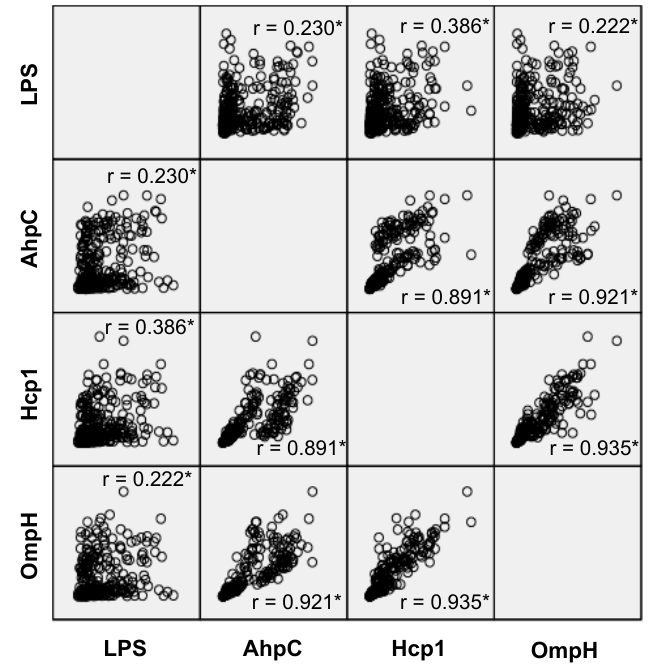
Figure 4. Scatter-plot relationship matrix between immunoglobulins G of anti- Burkholderia pseudomallei proteins; alkyl hydroperoxide reductase subunit C (AhpC), hemolysin-coregulated protein 1 (Hcp1), and putative outer membrane porin protein (OmpH), compared to the IgG of anti- Burkholderia pseudomallei lipopolysaccharide (LPS). The asterisks (*) indicate that correlation was significant at the 0.01 level.